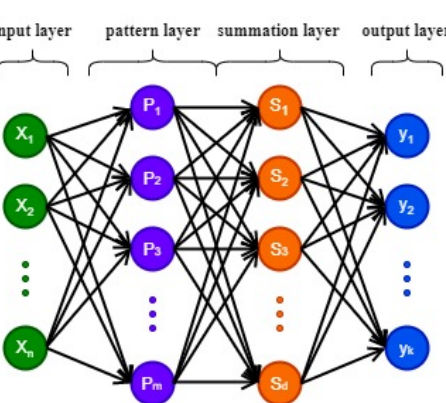
Figure 1. Schematic diagram of the architecture of the general regression neural network